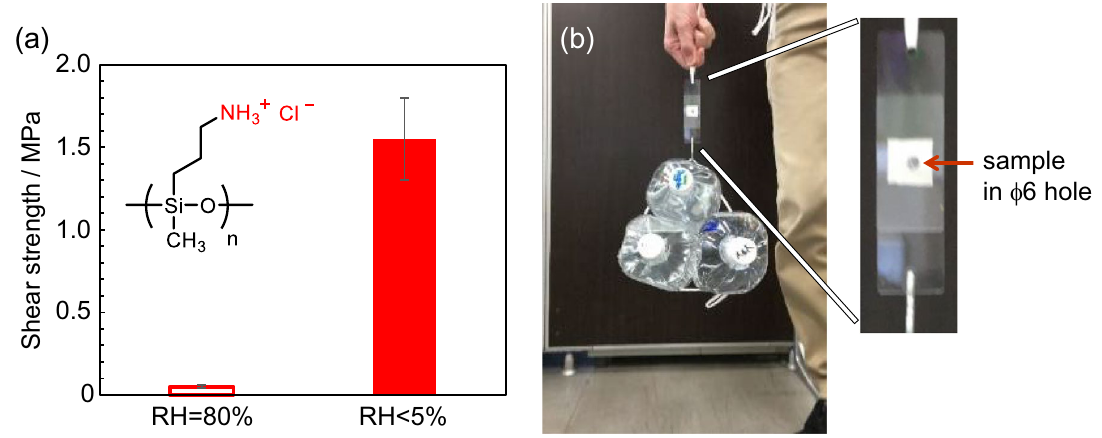
Figure 4. ( a ) Shear strength of moist- and dry-PSx(NH 3+ Cl − ) and ( b ) snapshot of the hanging test for dry- PSx(NH 3+ Cl − ). Arrow in the right enlarged picture indicates the polymer is in the fixation can hoist a 6-kg